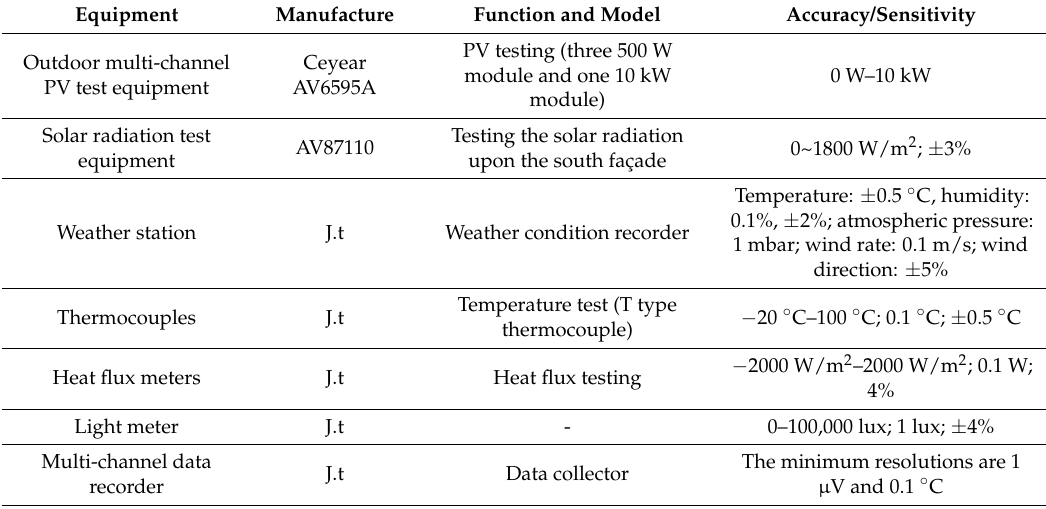
Table 2. The key instruments and their specifications